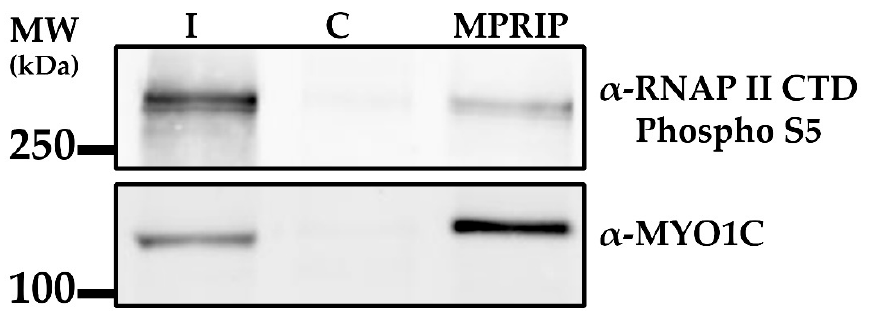
Figure 4. The immunoprecipitation assay confirms the existence of a MPRIP/RNAPII/MYO1C nuclear complex. The MPRIP immunoprecipitation was performed with HeLa nuclear lysates and the corresponding proteins were detected by Anti-RNAP II CTD Phospho S5 and anti-MYO1C antibodies. I—input 2%; C—control non-specific rabbit Immunoglobulin G. n = 3.